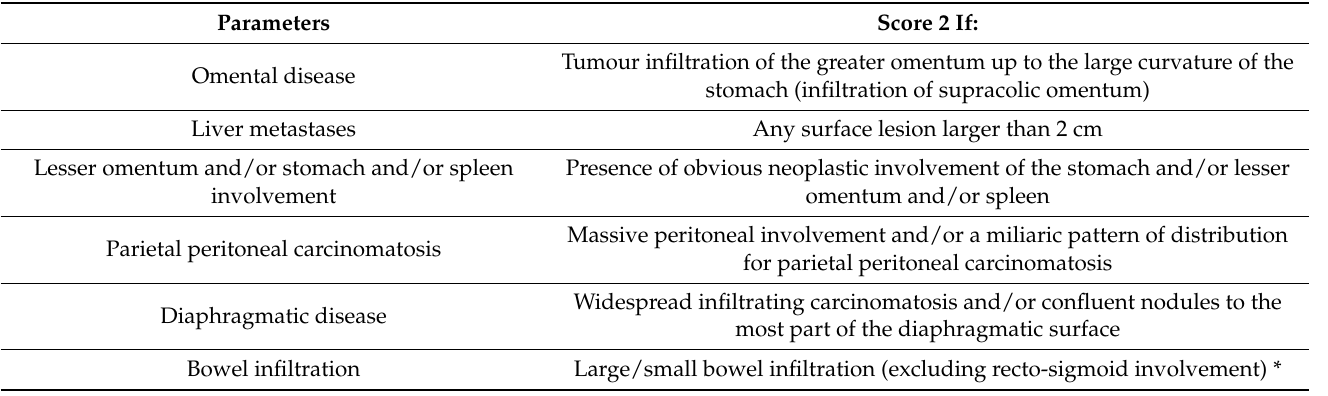
Table 3. Updated Fagotti score